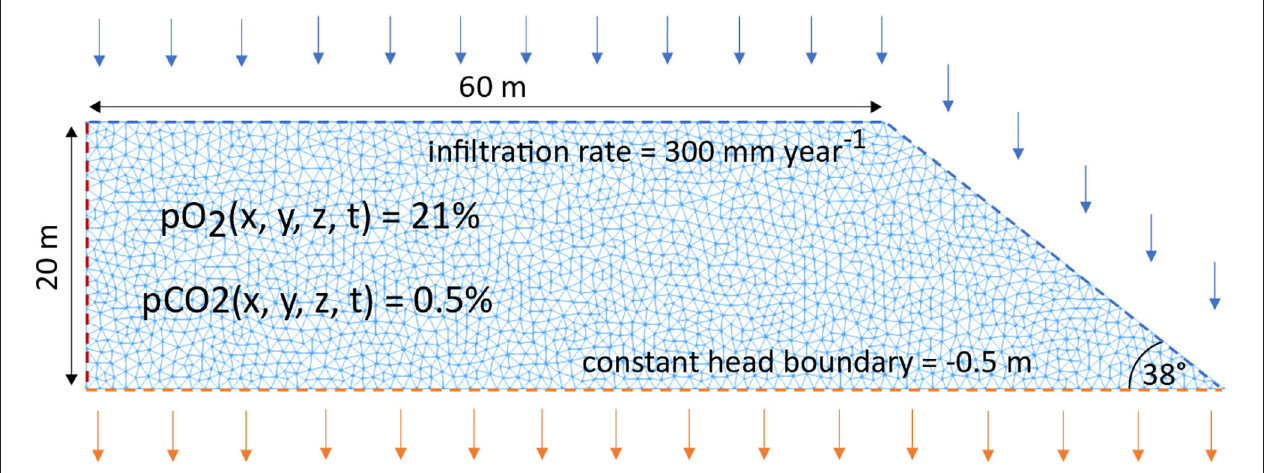
FIGURE 2 | Conceptual model for single bench, 2D WRP and triangular mesh. Input parameters shown here are consistent in all models investigated for the single bench scenario. For multi-bench models, the same infiltration rate was applied along the top and slopes of exposed surfaces, with the same constant head boundary assigned at the